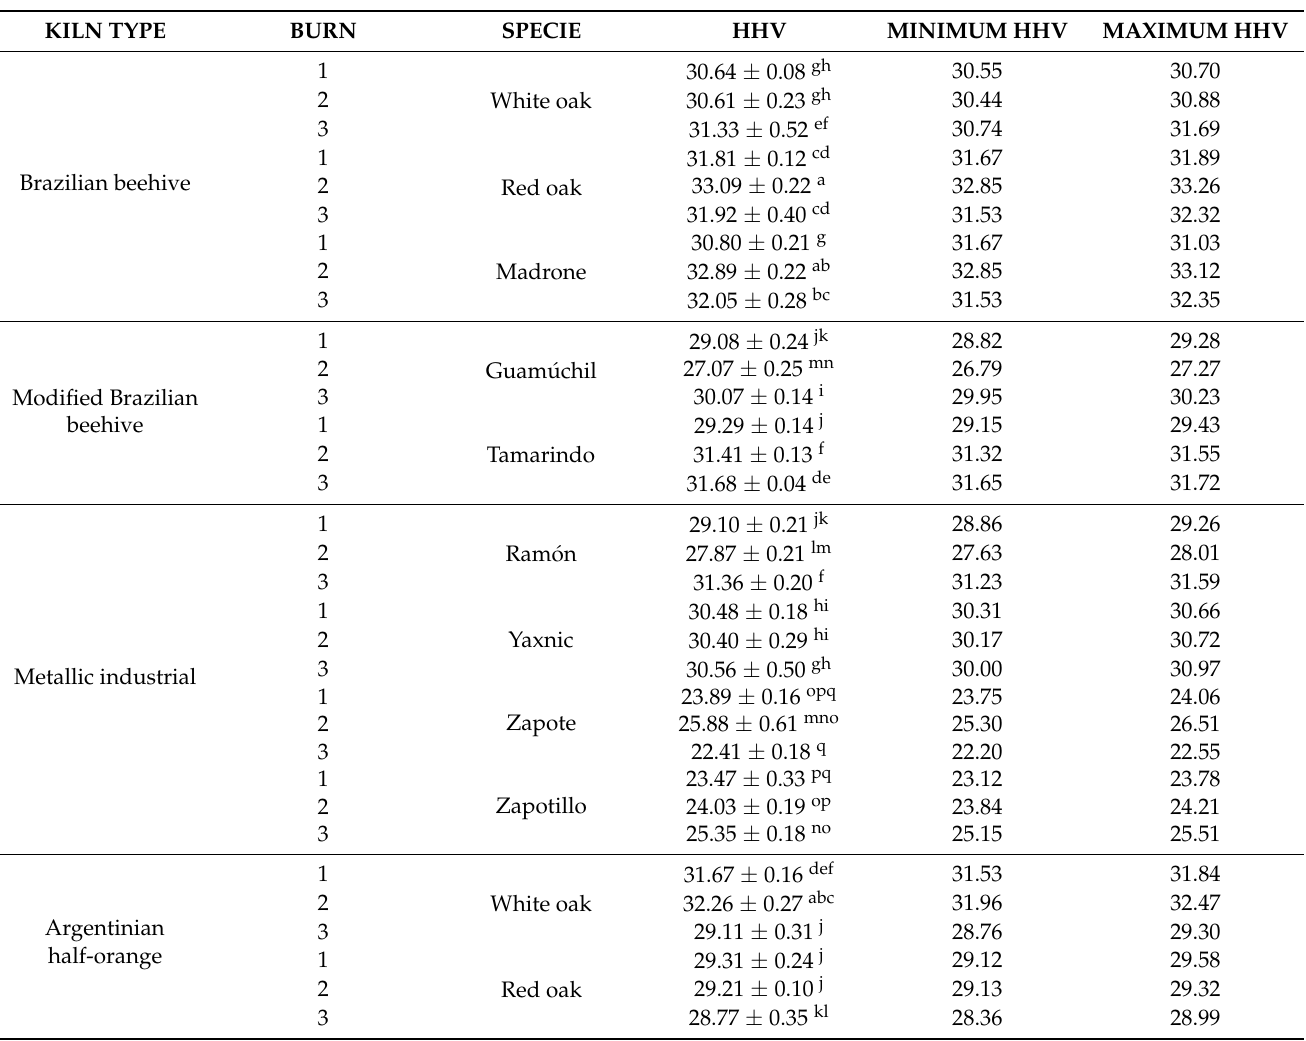
Table 11. Heating value (MJ kg − 1 ) of charcoal produced in four types of